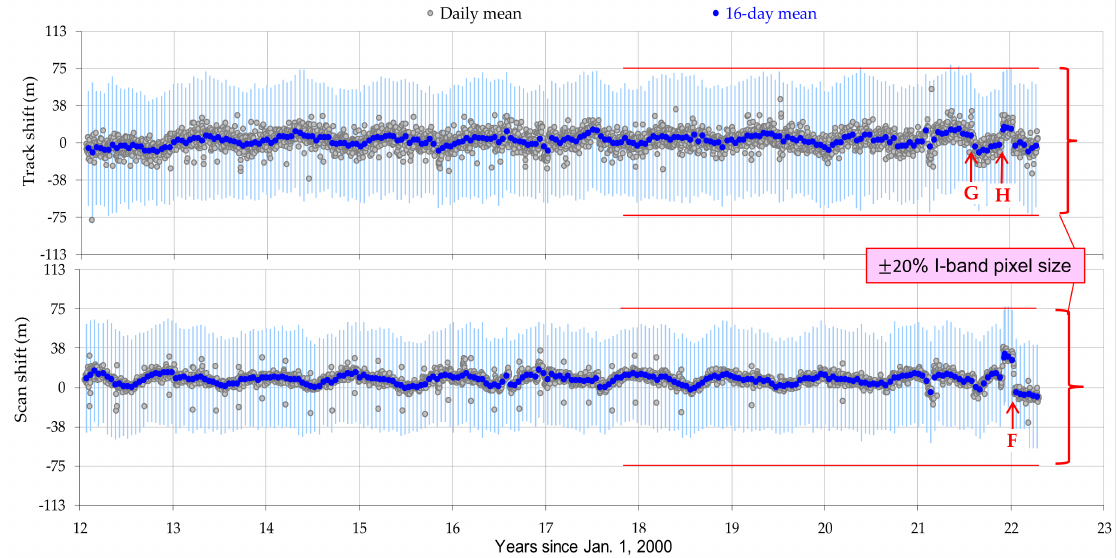
Figure 5. Measured SNPP VIIRS geolocation performance in Collection-2 in daily means, 16-day means, and 16-day uncertainties. “G” denotes an event on 3 August 2021 when the instrument was put in “safe hold” and the spacecraft was “sun pointing” for about 10 h that impacted thermal conditions of the instrument, which in turn impacted pointing and geolocation. “F” denotes LUT update on 13 January 2022 after an unexpected event of pointing shifts on 28 November 2021 (“H”).